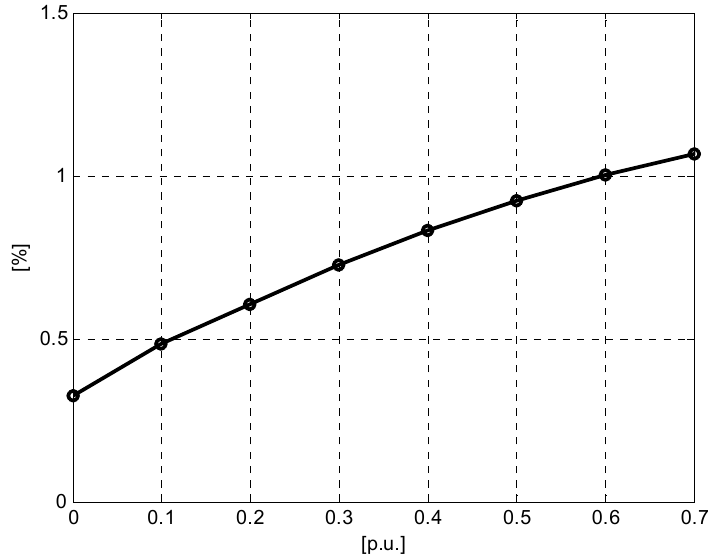
Figure 9. Reduction in the cost of energy served for the optimal storage solution in the reference Case 2, for increasing values of the generation